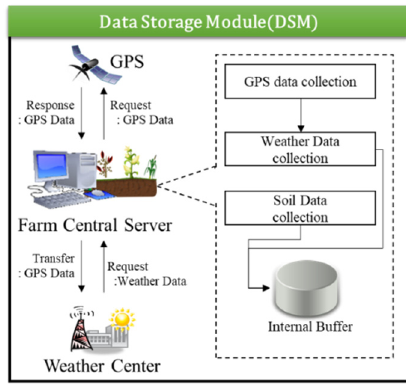
Figure 7. The structure of the data storage module (DSM).